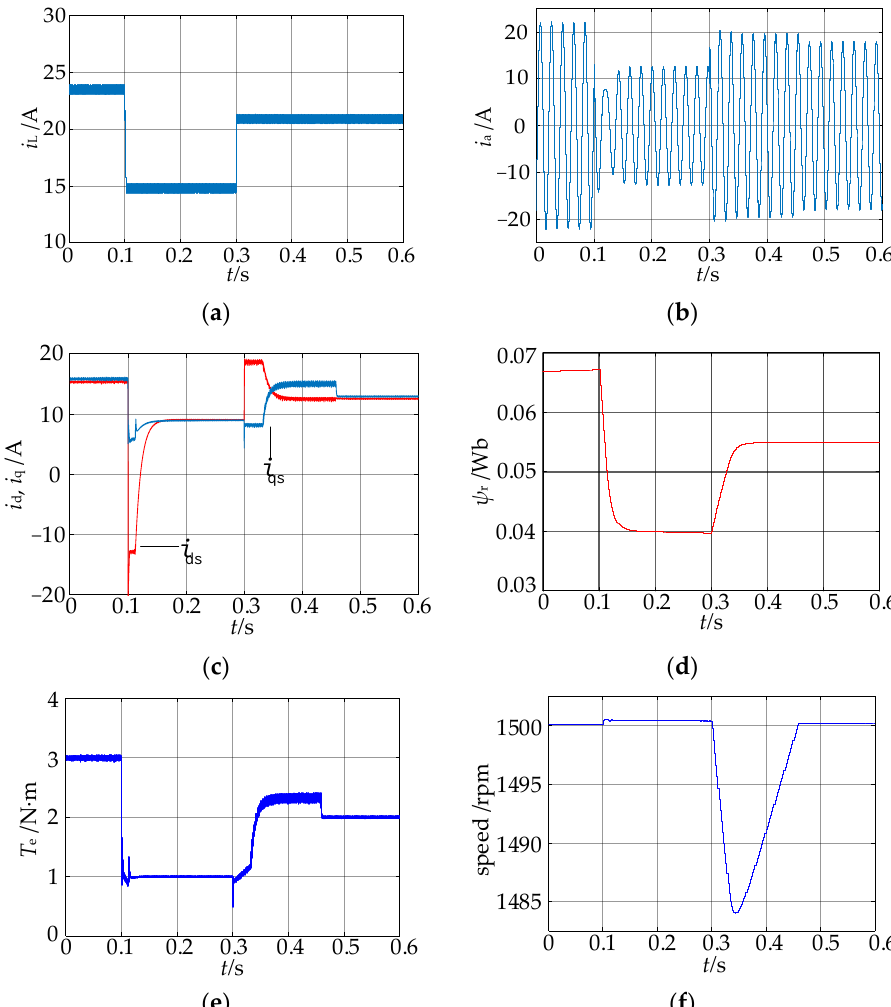
Figure 19. Simulation waveforms under the step perturbation of load torque. ( a ) i L ; ( b ) i a ; ( c ) i d and i q ; ( d ) ψ r ; ( e ) T e ; ( f ) speed.